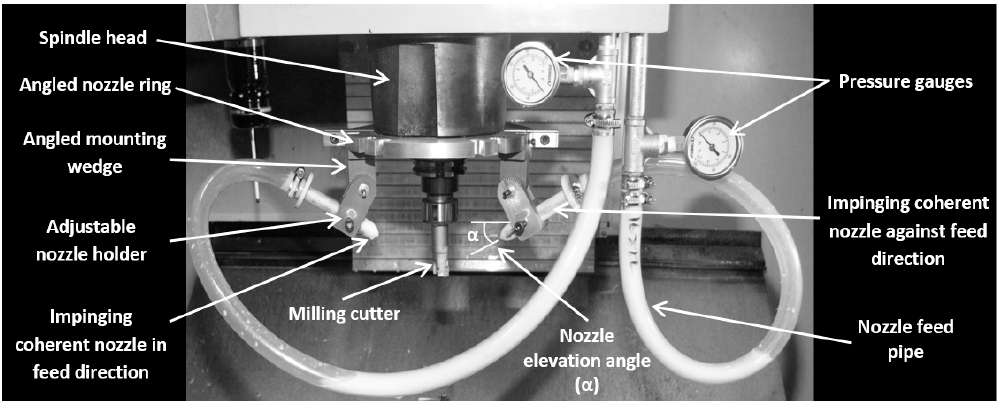
Figure 3. The Cut-list set-up (details of view A).